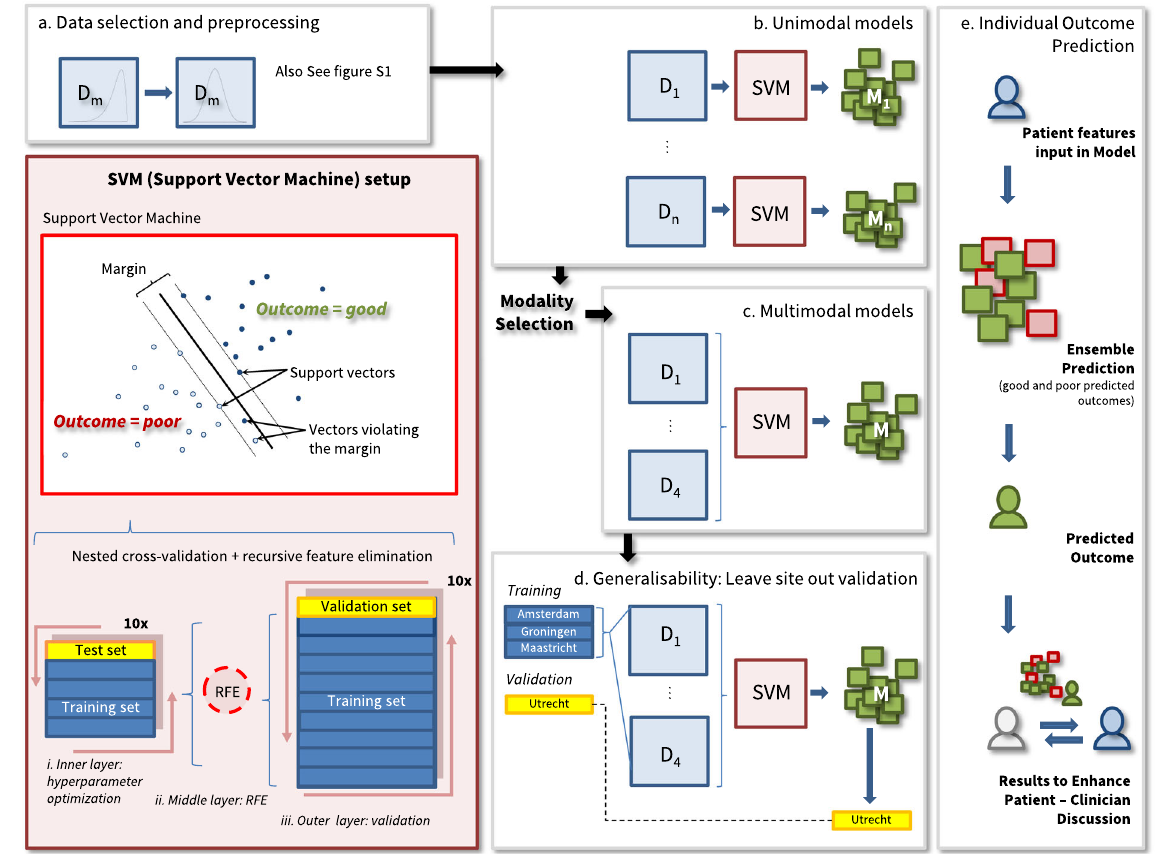
Fig. 2 Machine learning training and validation design. Machine learning pipeline. D = modality; M = Model; training sets in dark blue, test/ validation sets in yellow. a Data selection (see Supplementary Fig. 1 for details) and preprocessing including scaling and imputation. b Unimodal models, to identify the most informative modalities. c Multimodal models consisting of 2 – 4 modalities, including recursive feature elimination (RFE). d External validation of multimodal models using leave-one-site-out (LOSO) validation, where one of the four geographic sites is held out of model training and used for external validation; SVM (support vector machine) setup: RFE is part of the SVM pipeline; (i) In the inner layer, a CV loop is used to fi nd the optimal value for the cost hyperparameter C from 38 points equidistant in 2 log, starting at 0.0001 and ending at 37.07. C sets a penalty for violating the margin of the hyperplane; (ii) the middle layer employs a CV loop for RFE, a feature selection algorithm. It starts by including all available features in the model and iteratively eliminates the least informative features from it until the stopping criterion is met. The smallest set of features with performance within 10% of the best-performing set is selected; (iii) in the outer layer, a CV loop is used to de fi ne feature weights in the training set (9/10th of the data) and test the accuracy of the model in the validation set (1/10th of the data). Repetition of this procedure yields 10 models, which are repeated 50 times to reduce dependency on the choice of train-test partitions. The fi nal prediction for a patient is an ensemble constituting an average of 50